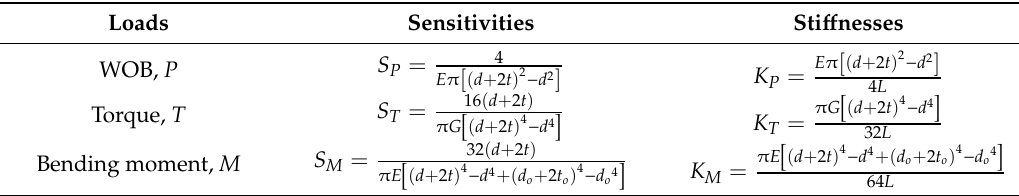
Figure 3. Load conditions of a measurement sub. Table 1. Expressions of basic characters of the elastic cell.